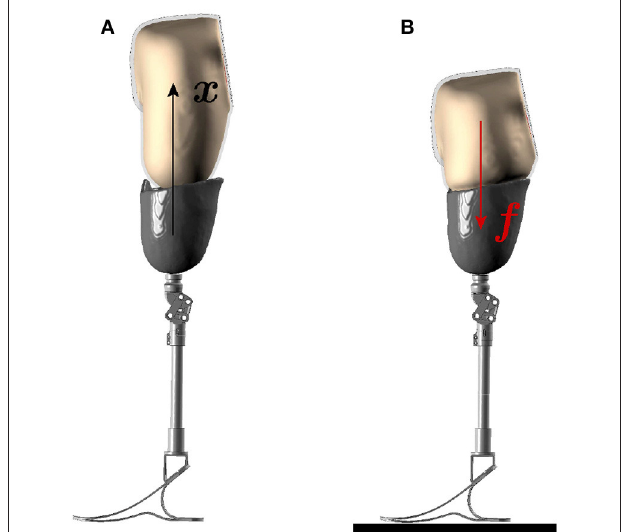
FIGURE 5 | Boundary conditions for FE analysis. The two stages of the socket donning analysis are illustrated here. (A) In the first stage, the socket is donned over the residual limb through prescribed motion boundary condition. (B) In the next stage, the patient’s body weight is applied on the femur in the socket-donned state as the prosthesis rests on the